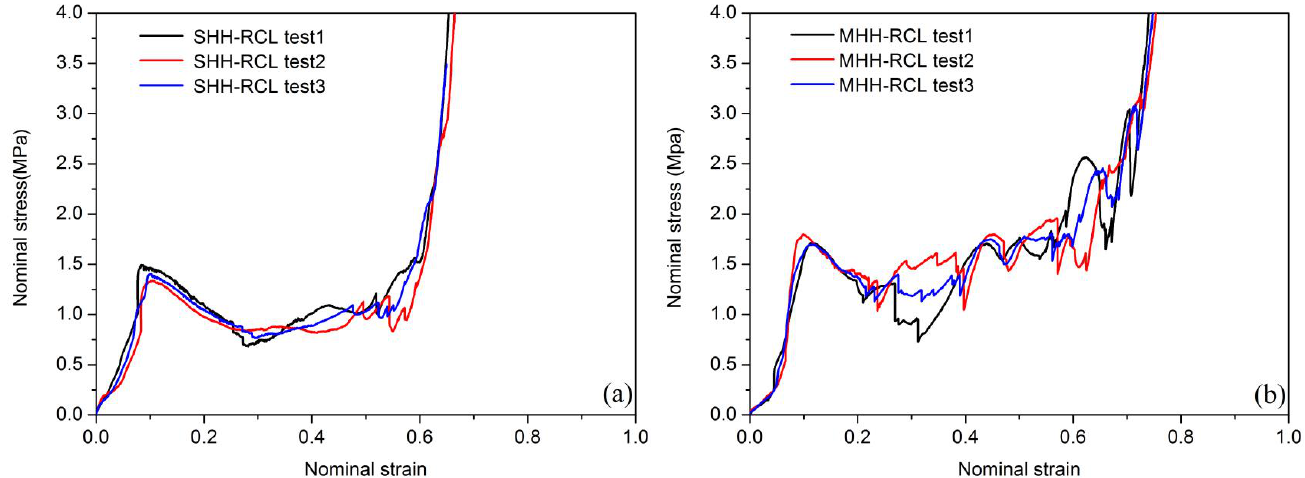
Figure 6. Nominal stress–strain curve of radial compression loading (RCL): ( a ) SHH-RCL test, ( b ) MHH-RCL test.